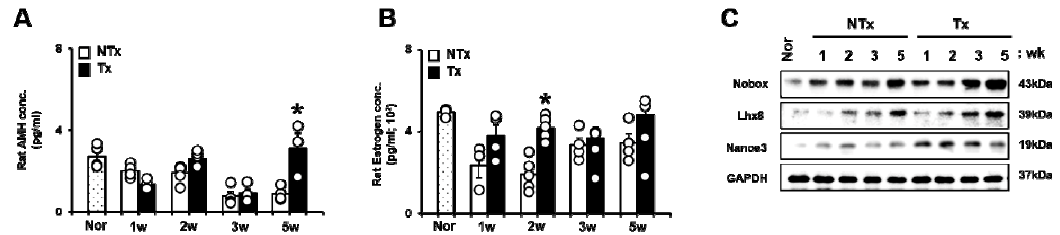
Figure 5. Effect of PD-MSCs transplantation on gene expression related to folliculogenesis in the ovary tissues of OVX rats. AMH and E2 hormone levels in the serum of NTx and Tx were analyzed by the ELISA assay ( A and B) . Nobox , Lhx8 , and Nanos3 protein expression related to folliculogenesis in NTx and Tx were analyzed by Western blot ( C ). The data are representative of three independent experiments and expressed as means ± SD. * p < 0.05: NTx vs. Tx